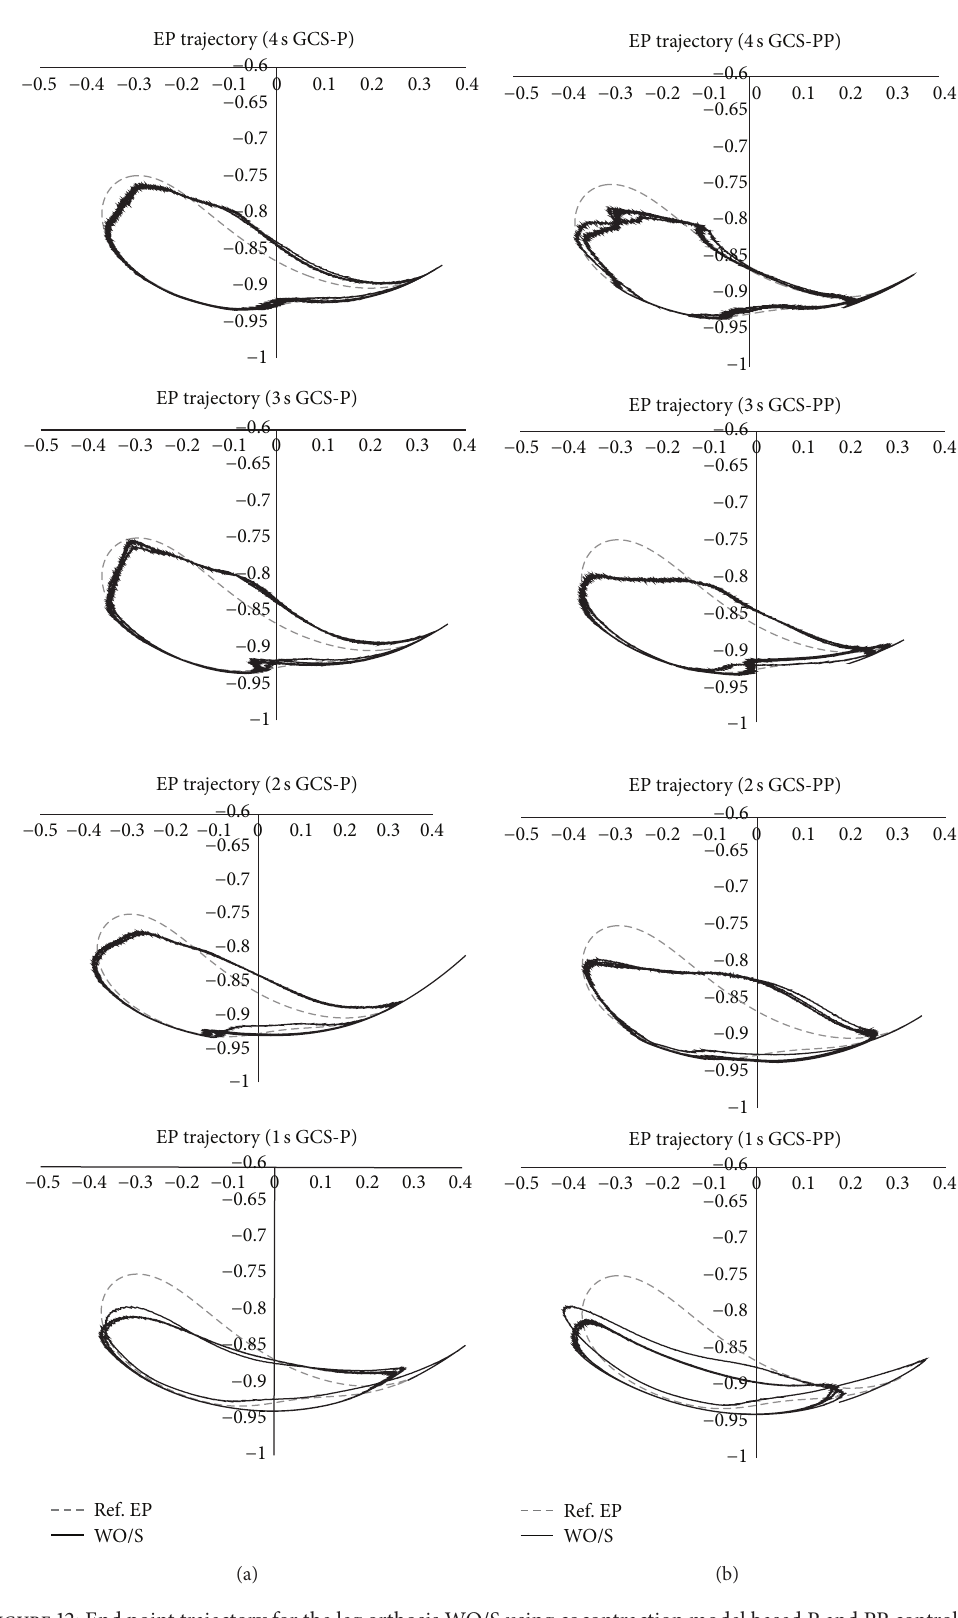
Figure 12: End point trajectory for the leg orthosis WO/S using cocontraction model based P and PP